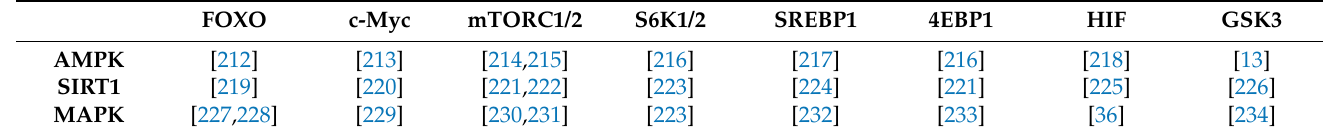
Table 3. AMPK-SIRT1-MAPK network connects to AKT